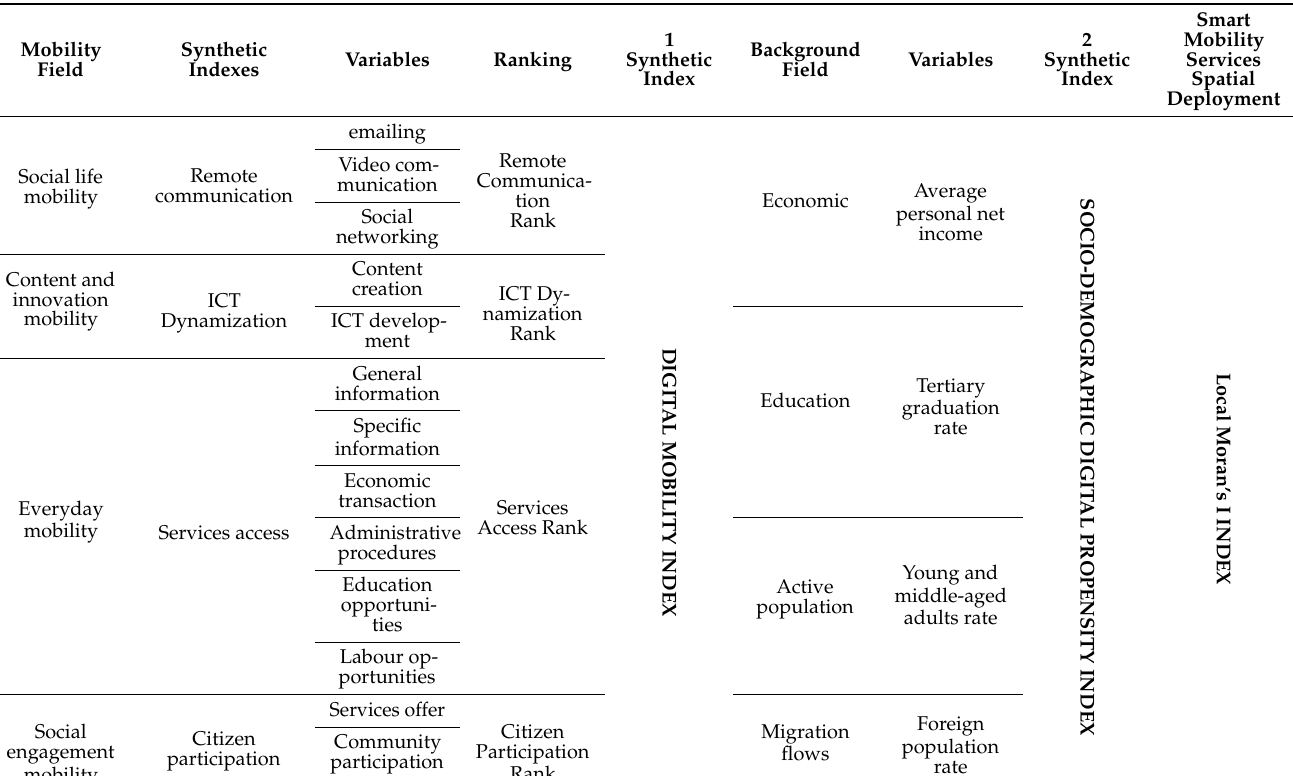
Table 1. Synthetic indexes conceptual